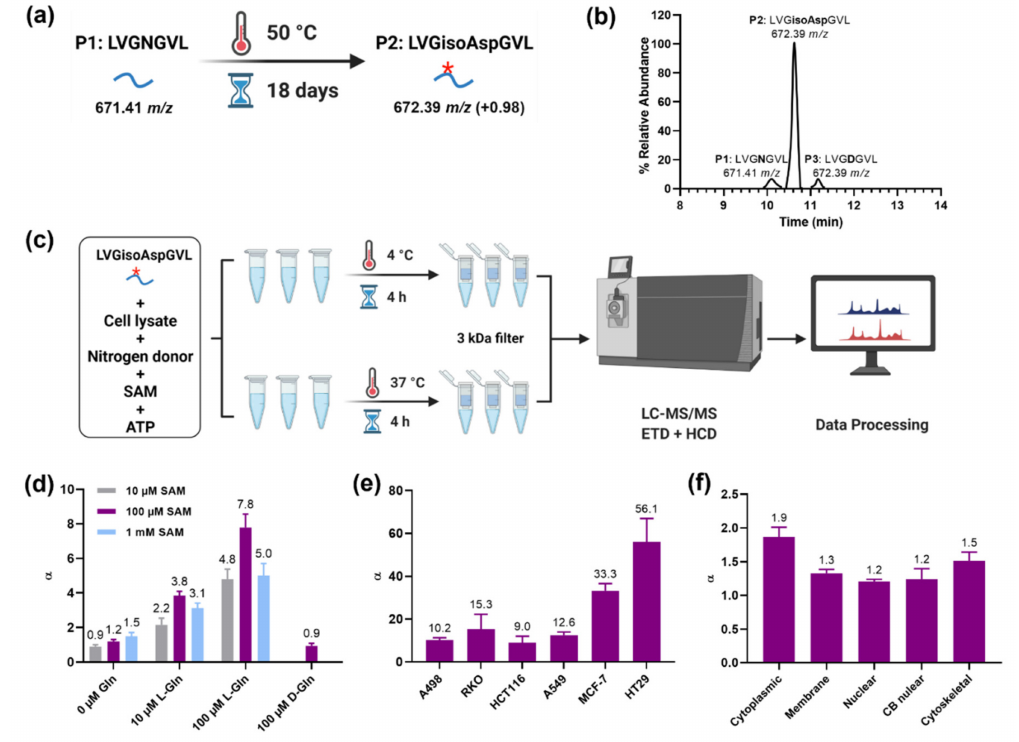
Figure 2. Discovery of PSIAL activity on synthetic isoAsp-containing peptide. ( a ) Artificial deami- dation of the synthetic peptide LVGNGVL (P1) to LVGisoAspGVL (P2) via incubating at 50 ◦ C for 18 days. *: isoAsp. ( b ) The chromatogram of the aged peptide above in three forms with Asn (P1), isoAsp (P2), and Asp (P3). ( c ) The scheme of testing PSIAL activity in cell lysate using aged P1 and cofactors. ( d ) The effects of cofactors (Gln and SAM) with different concentrations on PSIAL activity. ( e ) Comparison of PSIAL activities among different cancer cell lines by measuring the fold-change α of the relative abundance of the Asn form of peptide in 37 ◦ C incubation versus 4 ◦ C. ( f ) Comparisons of PSIAL activities among different subfractions of HT29 cell